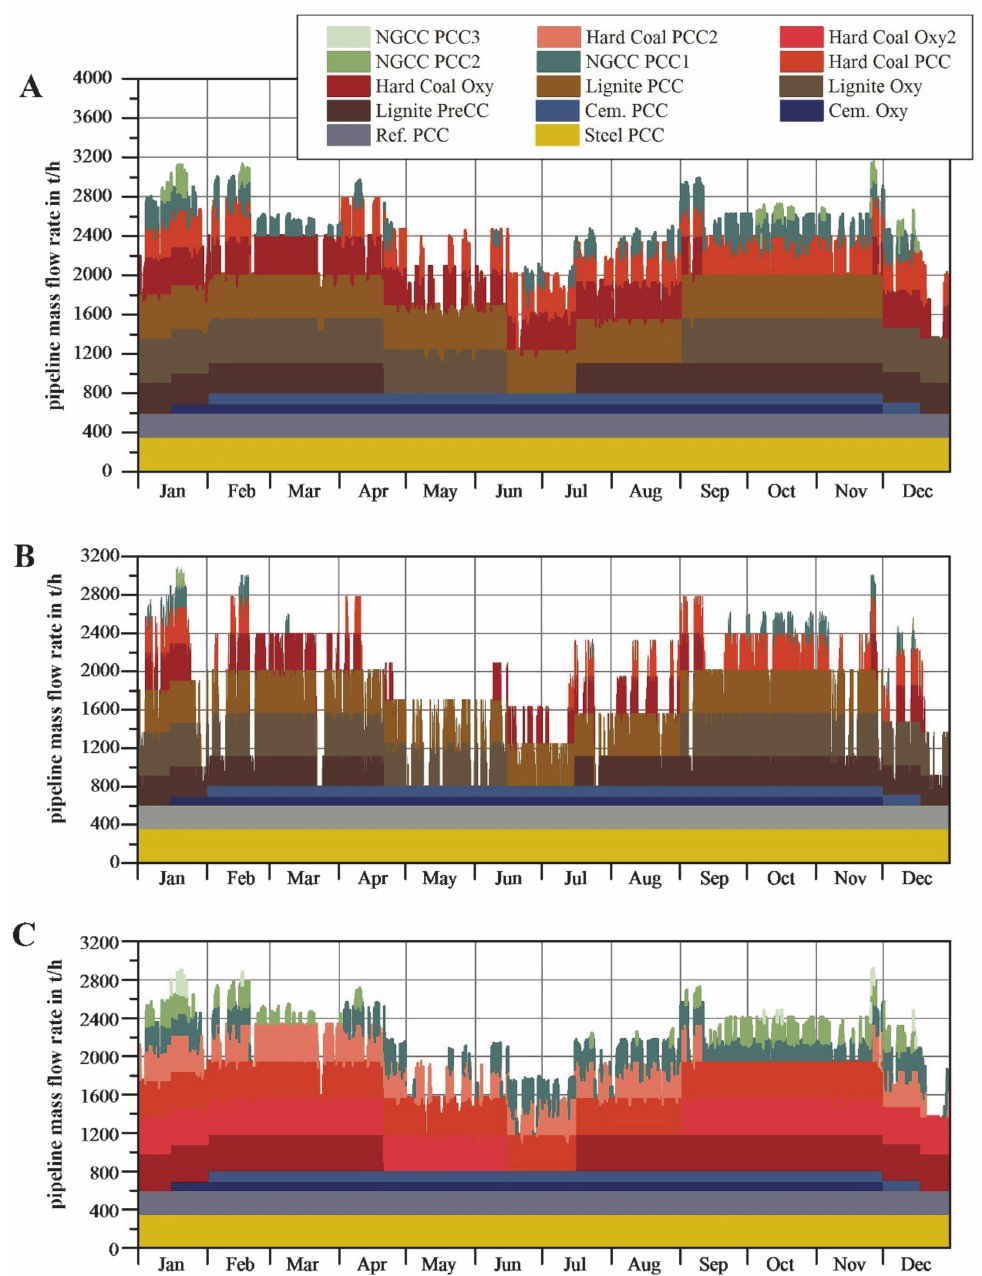
Figure 4. Stacked pipeline mass flow rates in the three examined energy mix scenarios during one year: ( A ) “RE 27%”, ( B ) “RE 45%” and ( C ) “No lignite”. (Note that the plants NGCC PCC3, Hard Coal PCC2, and Hard Coal Oxy2 occur only in scenario “No